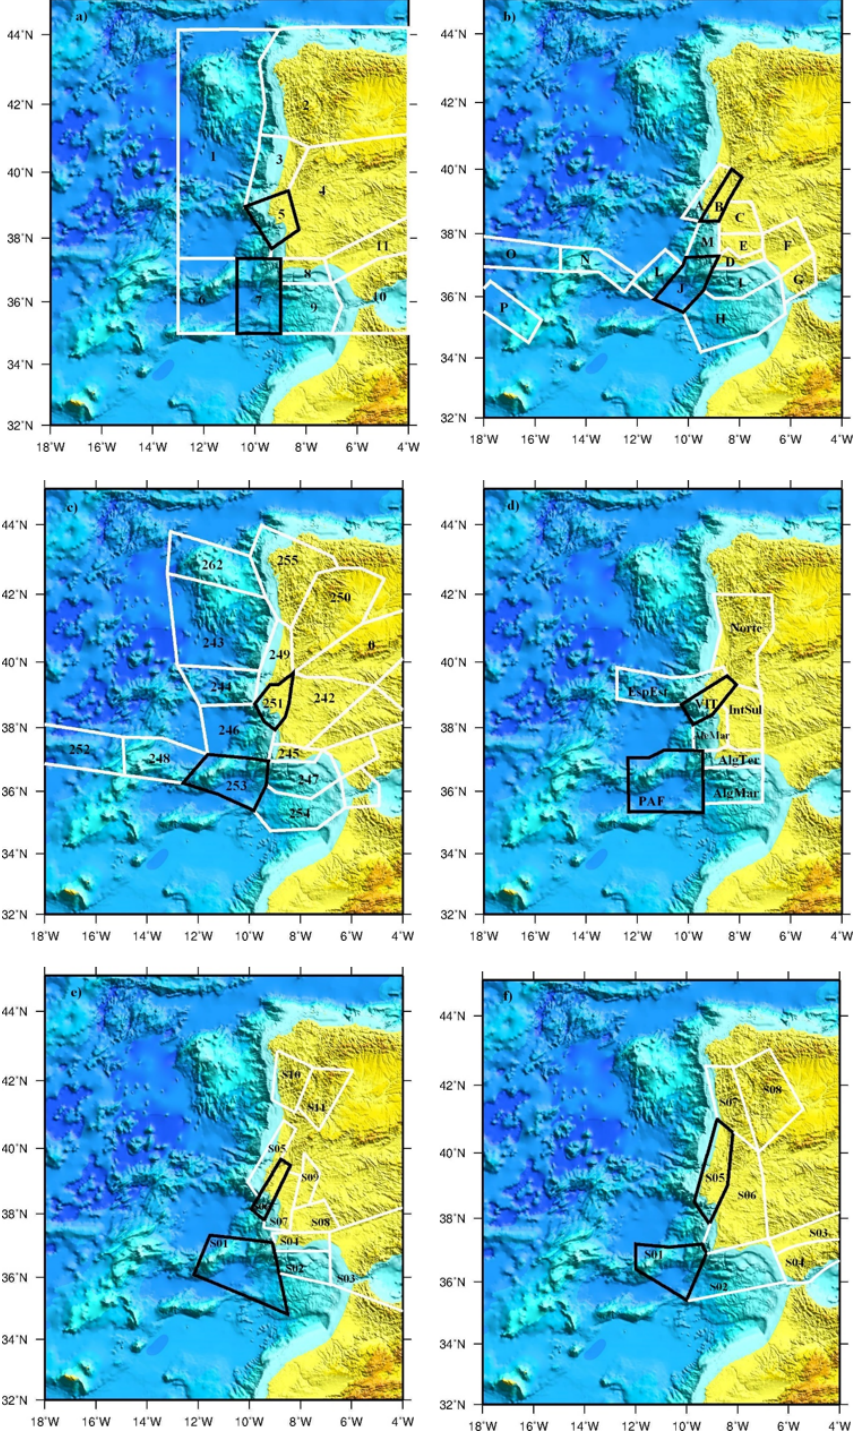
Figure 3. Seismogenic zones proposed for the five PSHA studies analysed in this work. The zones corresponding to Lower Tagus Valley (LTV) sources and 1755 earthquake selected for sanity check are outlined in black. (a) The National Annexes of Eurocode 8 (EC8), adapted from Campos Costa et al. (2008). (b) The ERSTA study, adapted from Carrilho et al. (2010). (c) The SHARE study, adapted from Woessner et al. (2015). (d) The QREN study, adapted from Matias and Teves-Costa (2011a,b). (e,f) Adapted from the Vilanova and Fonseca (2007) study. Panel (e) is seismic zonation SA and panel (f) is seismic zonation SB.